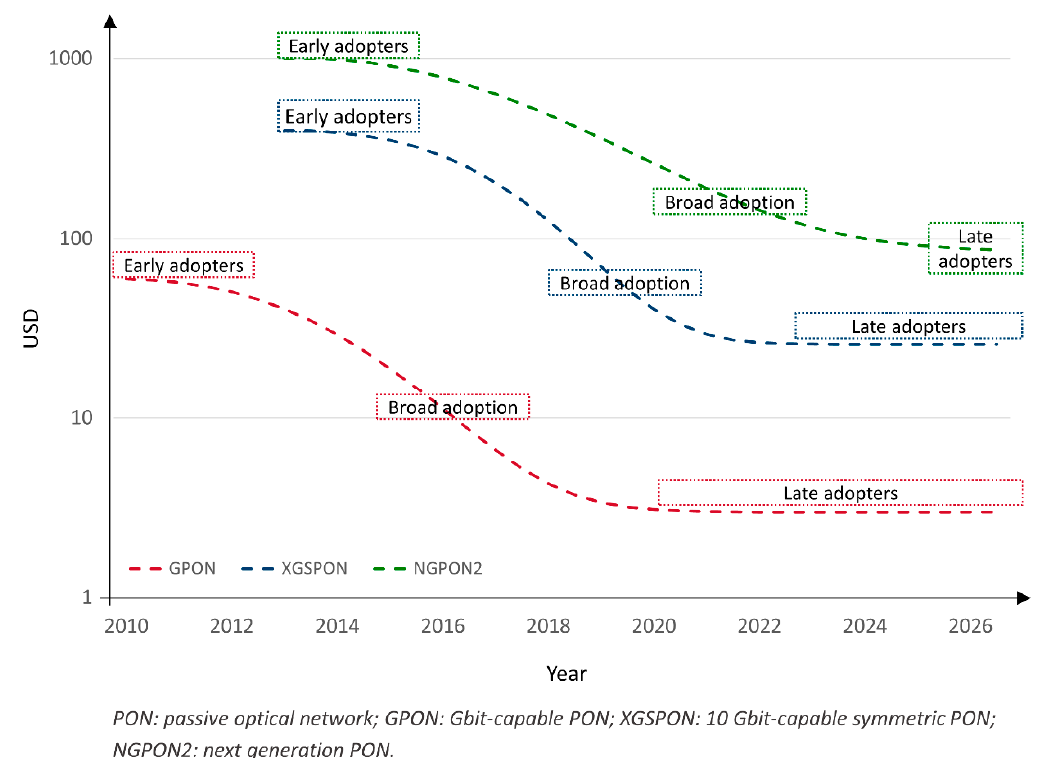
Figure 9. Representation of average price evolution of PON technology for GPON, XGSPON, and NGPON2 bulk type BOSA (not PIC based). Pricing was empirically collected along the years from several providers and averaged in the graph.